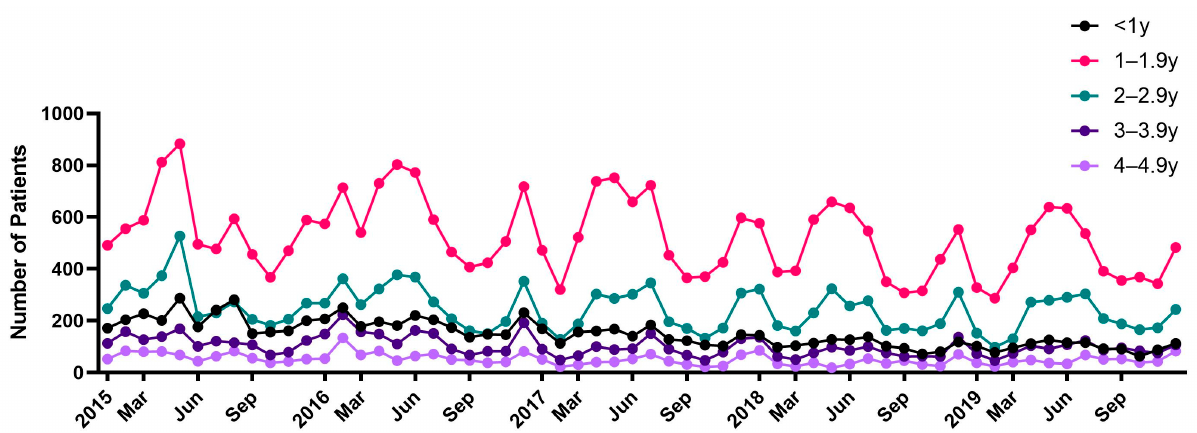
Figure 3. Annual incidence and age-standardized incidence rate of febrile convulsion from 2015 to 2019.